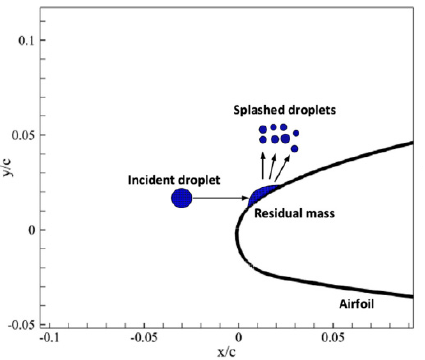
Figure 15. Simplification of droplet splashing for 2D simulation.